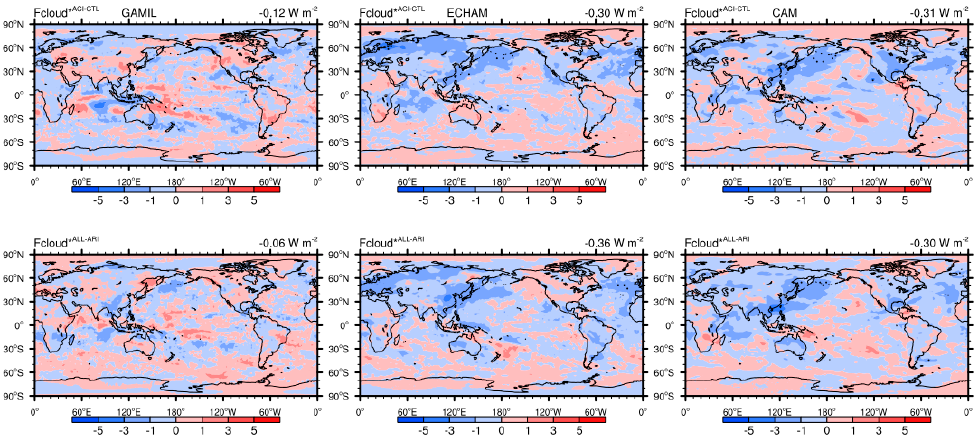
Figure 6. Anthropogenic aerosol e ff ects on shortwave cloud forcing from Twomey e ff ect with the GAMIL (left), ECHAM (middle), and CAM (right) models. The upper panel (Fcloud *ACI − CTL ) shows the di ff erences in shortwave cloud forcing between the ACI and CTL experiments. The lower panel (Fcloud *ALL − ARI ) shows the di ff erences between the ALL and ARI experiments. The number on the top right of the figure denotes the ensemble average of global annual mean values. Di ff erences significant at the 10% level of the Student’s t -test are depicted by